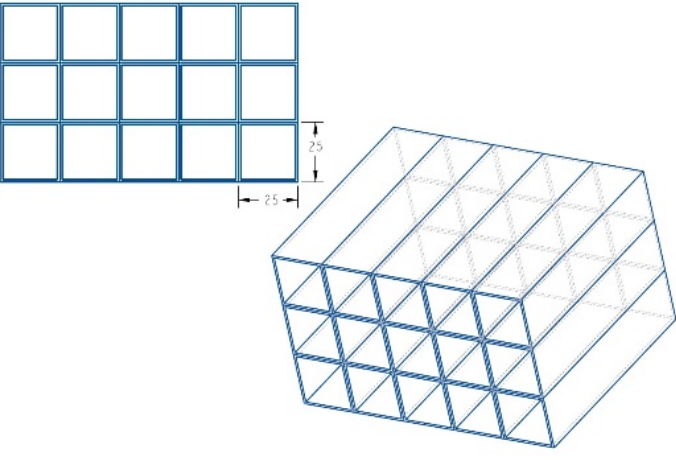
Figure 19. Vent panel model.